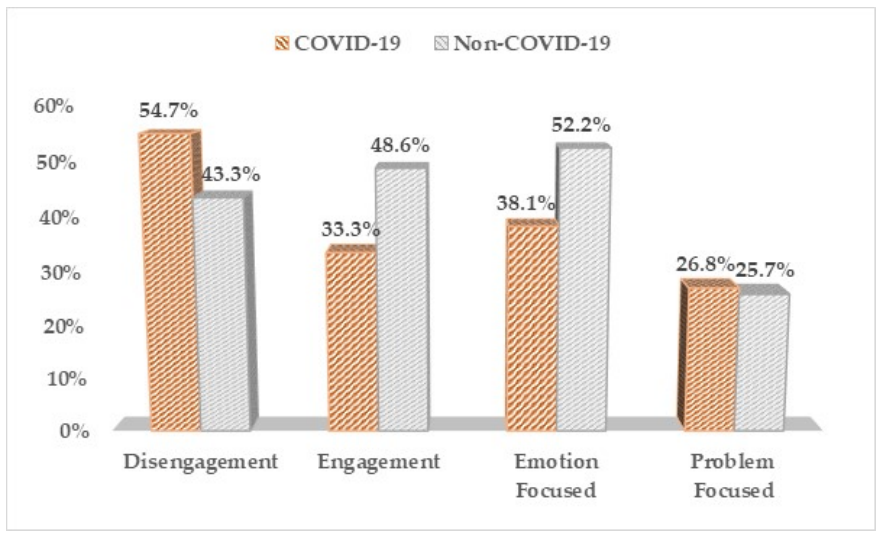
Table 3. HADS questionnaire results between COVID-19 positive and negative pregnant women.